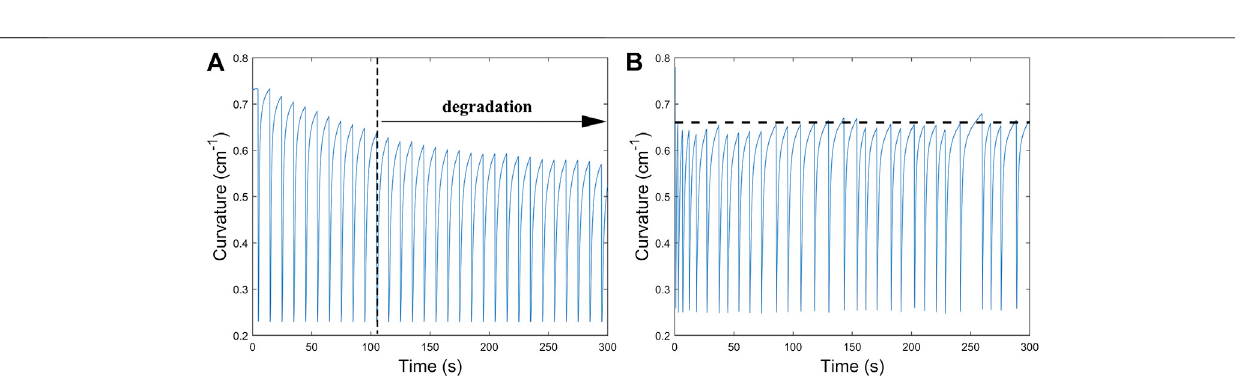
FIGURE 5 | Comparison of curvature range when cycling the actuator, open-loop (A) and closed-loop (B) . With feedback control that varies the cooling time, the rangeofcurvaturedoesnotdrift,keepingtheactuatorrelaxtoasimilarpositionatthestartofeachcycle.Bycomparison,theactuatorstartedtodegradeataround100 s with open-loop control